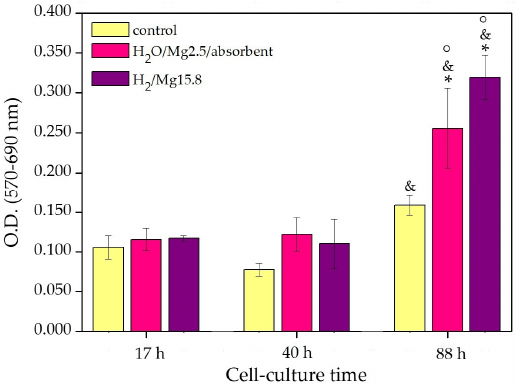
Figure 7. Metabolic activity MTT test of Saos-2 cells grown on native 3D PCL porous scaffolds (control), 3D PCL porous scaffolds processed with Φ H 2 O 100% (H 2 O/Mg2.5/absorbent), and 3D PCL porous scaffolds processed with Φ H 2 100% (H 2 /Mg15.8) at different culture times (17, 40, and 88 h). Significant differences resulted from the two-way analysis of variance (ANOVA) and Bonferroni’s test. Note: ° = p < 0.05 vs. control; * = p < 0.05 vs. 17 h; & = p < 0.05 vs. 40 h.